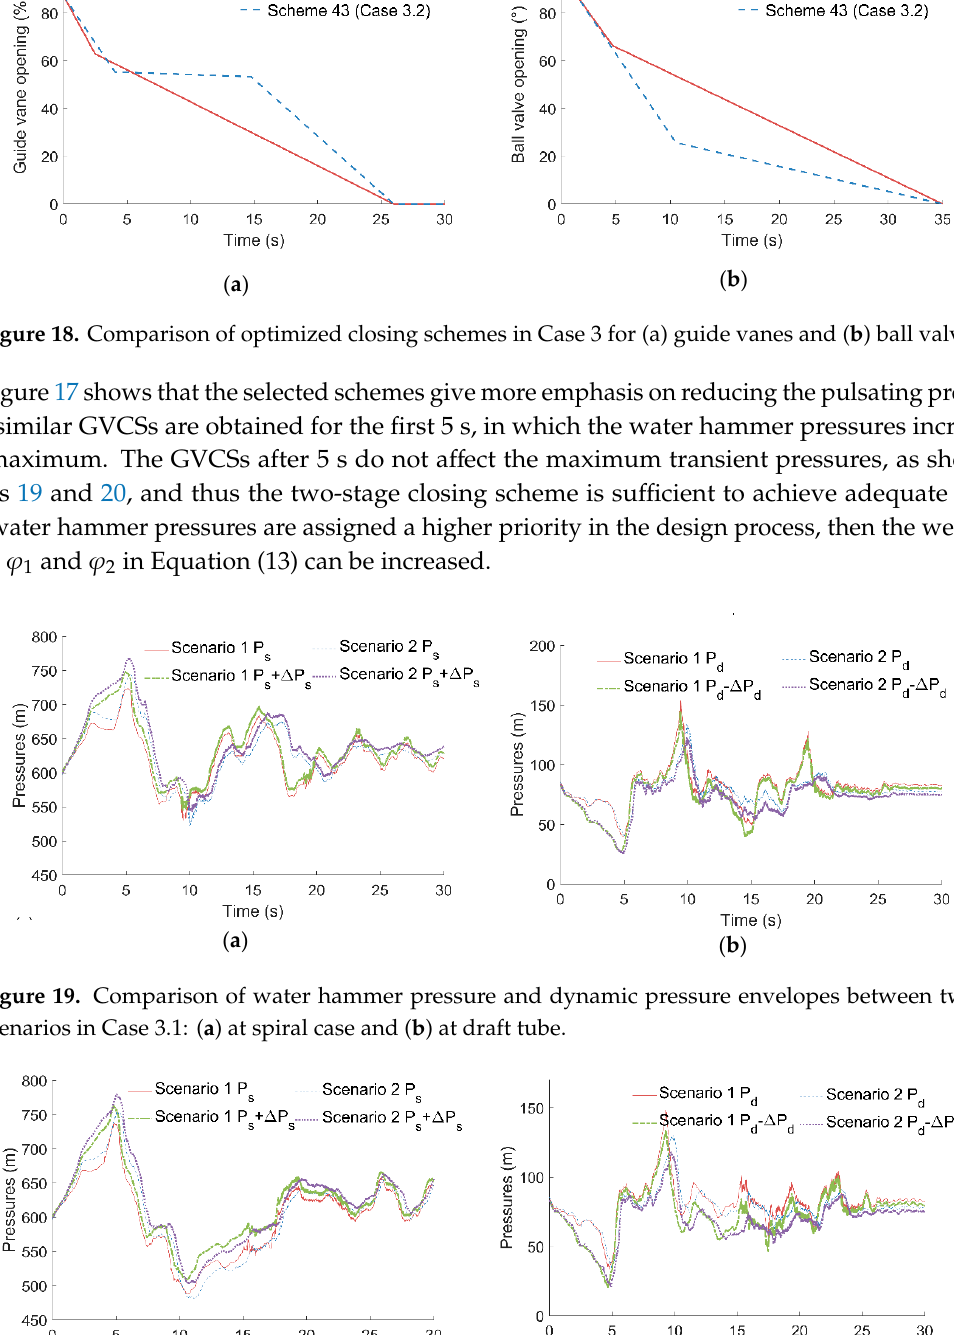
Figure 17. Pareto fronts obtained by different guide vane closing schemes in Case 3.